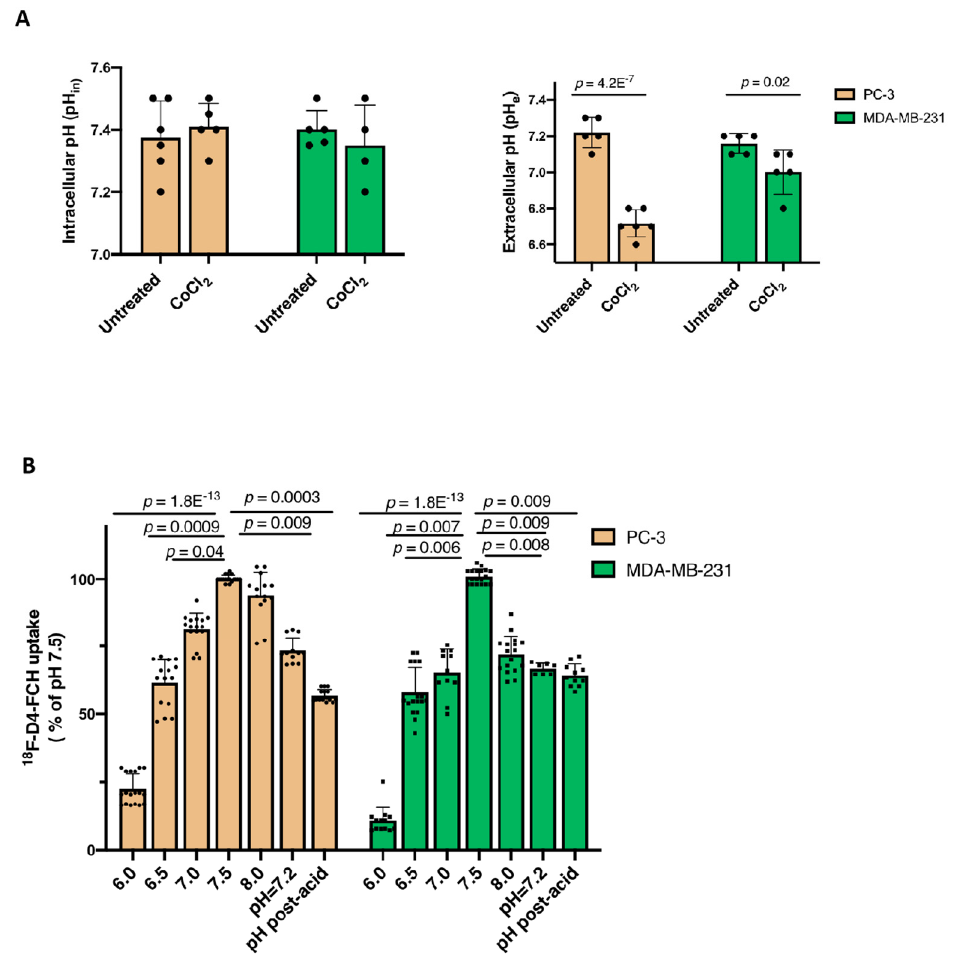
Figure 3. The investigation of the pH on the uptake of [ 18 F]-D4-FCH. ( A ) The intracellular pH (pH in ) and extracellular pH (pH e ) were assessed in the cells following the treatment with 200 µM CoCl 2 for 24 h. ( B ) Following a 24 h incubation under normoxic conditions, PC-3 and MDA-MB-231 cells were incubated with 0.37 MBq [ 18 F]-D4-FCH in pH-adjusted uptake media (pH e between 6.0 and 8.0) without CO 2 buffering for 1 h. The data presented are the mean ± standard deviation. One-way ANOVA with post-hoc Tukey’s multiple comparison tests were carried out.